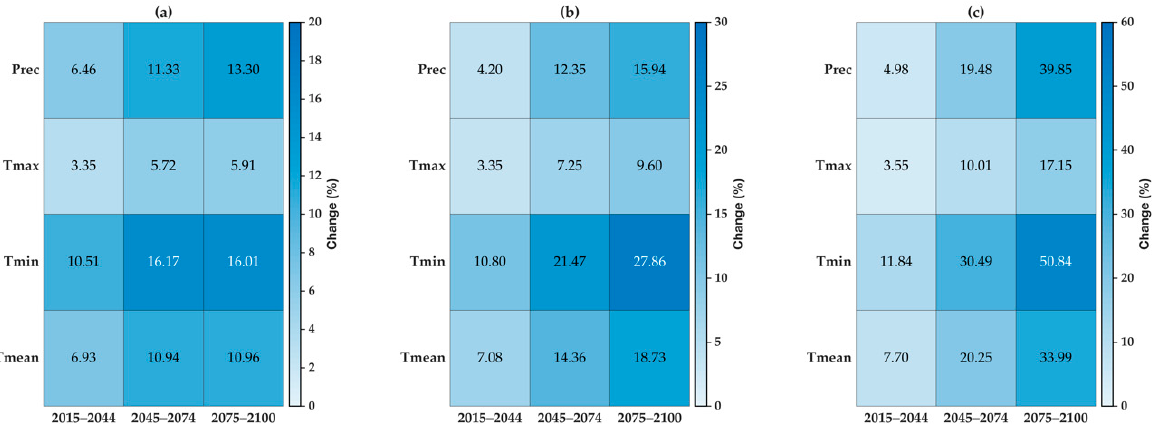
Figure 3. Projected changes [near-future (2015–2044), mid-future (2045–2074), distant-future (2075–2100)] in precipitation amount, Tmax, Tmin and Tmean under ( a ) SSP1-2.6 ( b ) SSP2-4.5 and ( c ) SSP5-8.5 over GRB.